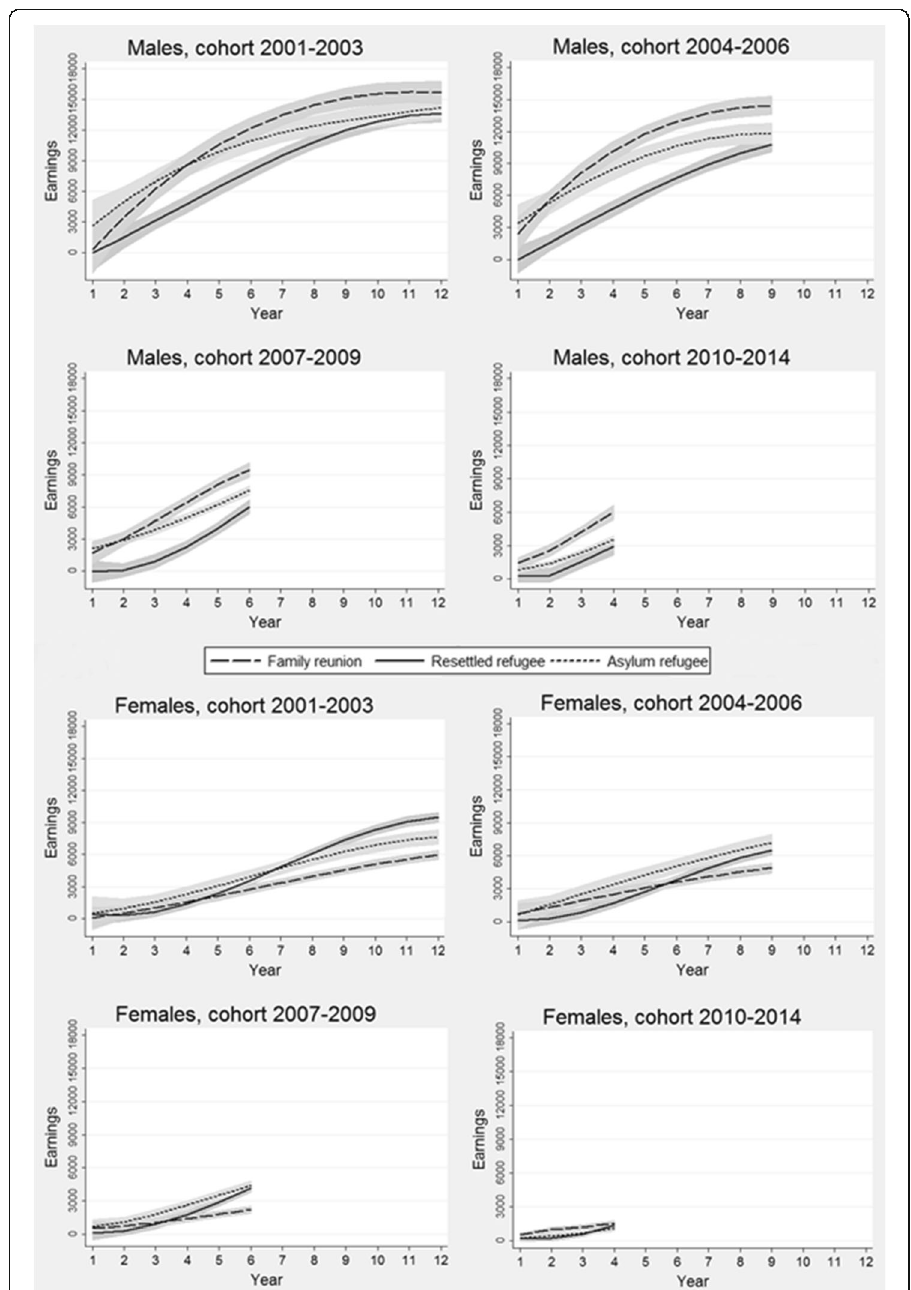
Fig. 5 The predicted annual earnings (EUR), including zeros, by admission category, migration cohort and duration of stay among individuals aged 25 – 60,